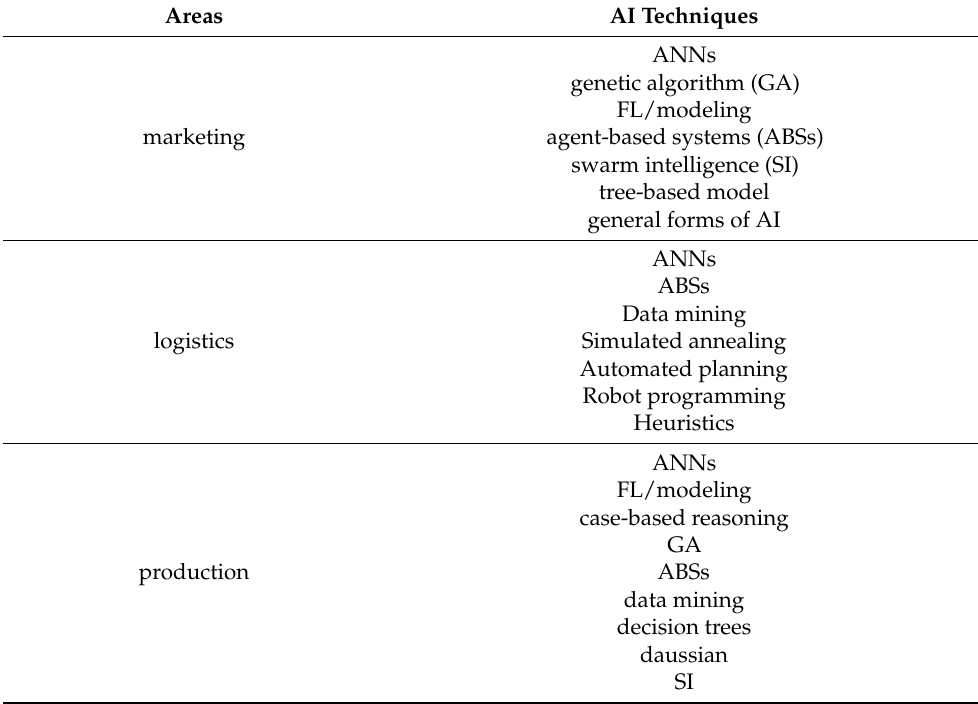
Table 1. Artificial Intelligence Techniques and